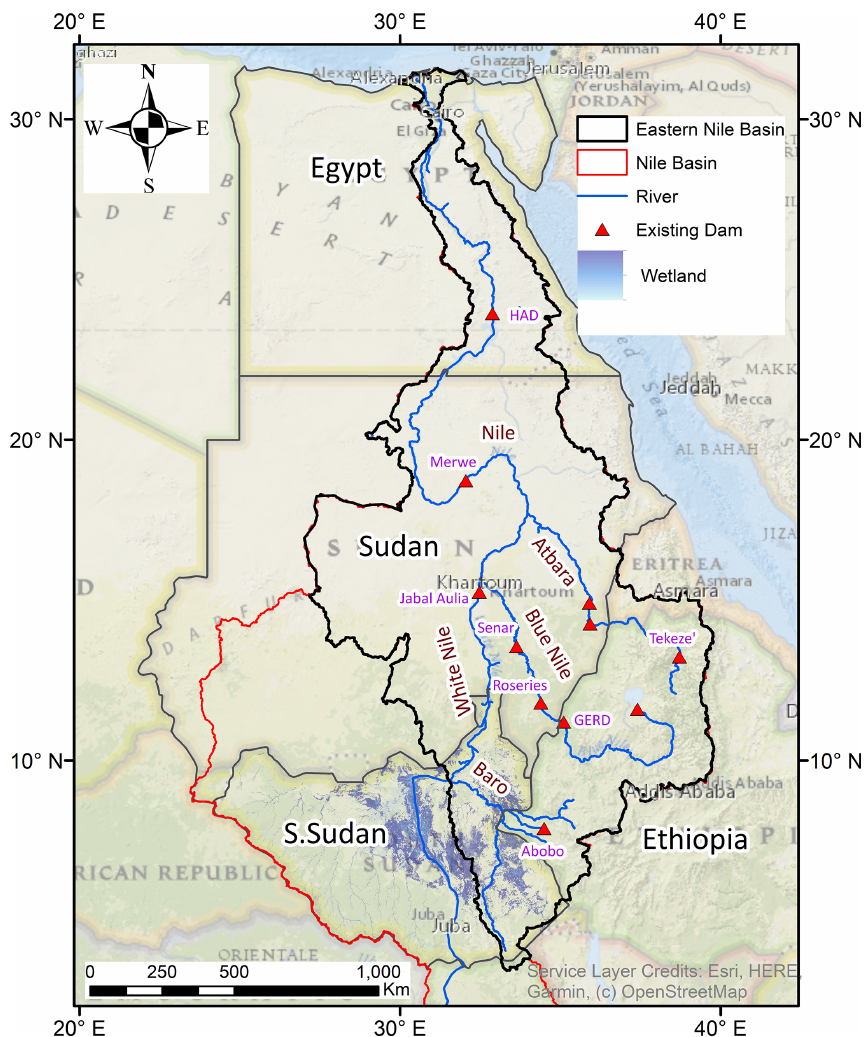
Figure 1. The Nile River basin (red line) and the Eastern Nile Basin (black line) with the three main riparian countries (Egypt, Sudan, and Ethiopia) (retrieved from Esri, 2021).